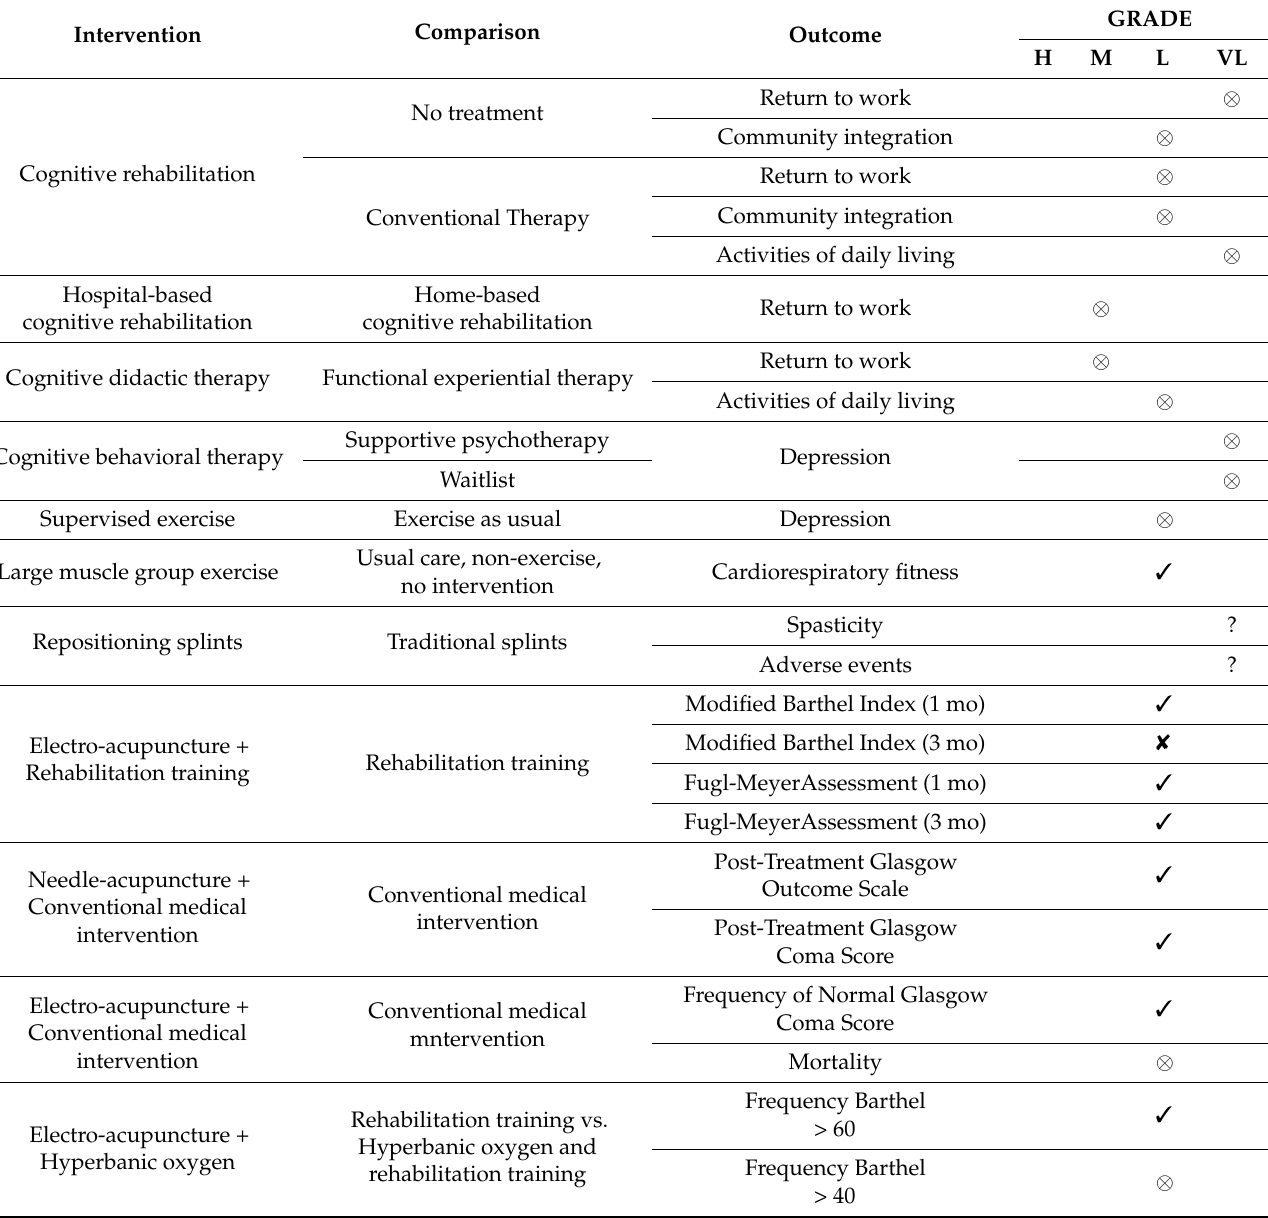
Table 3. Evidence map of non-pharmacological